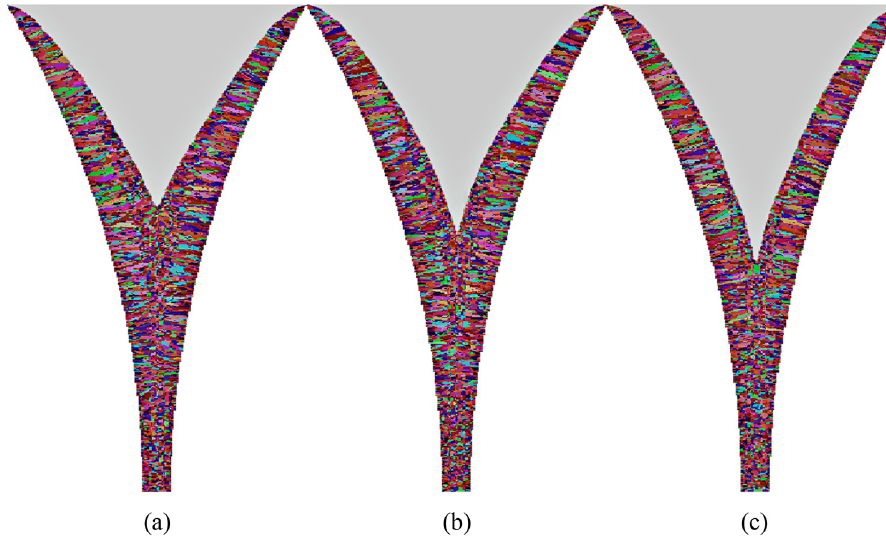
Figure 3: Solidi fi cation microstructure of molten pool at di ff erent casting temperatures. ( a ) 1,130°C, ( b ) 1,150°C, and ( c ) 1,180°C.